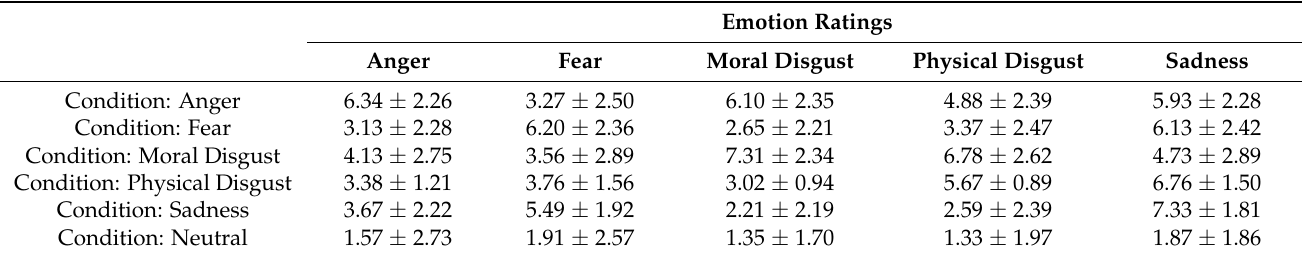
Table 1. Means and standard deviation of the emotional ratings across the six experimental conditions (Experiment